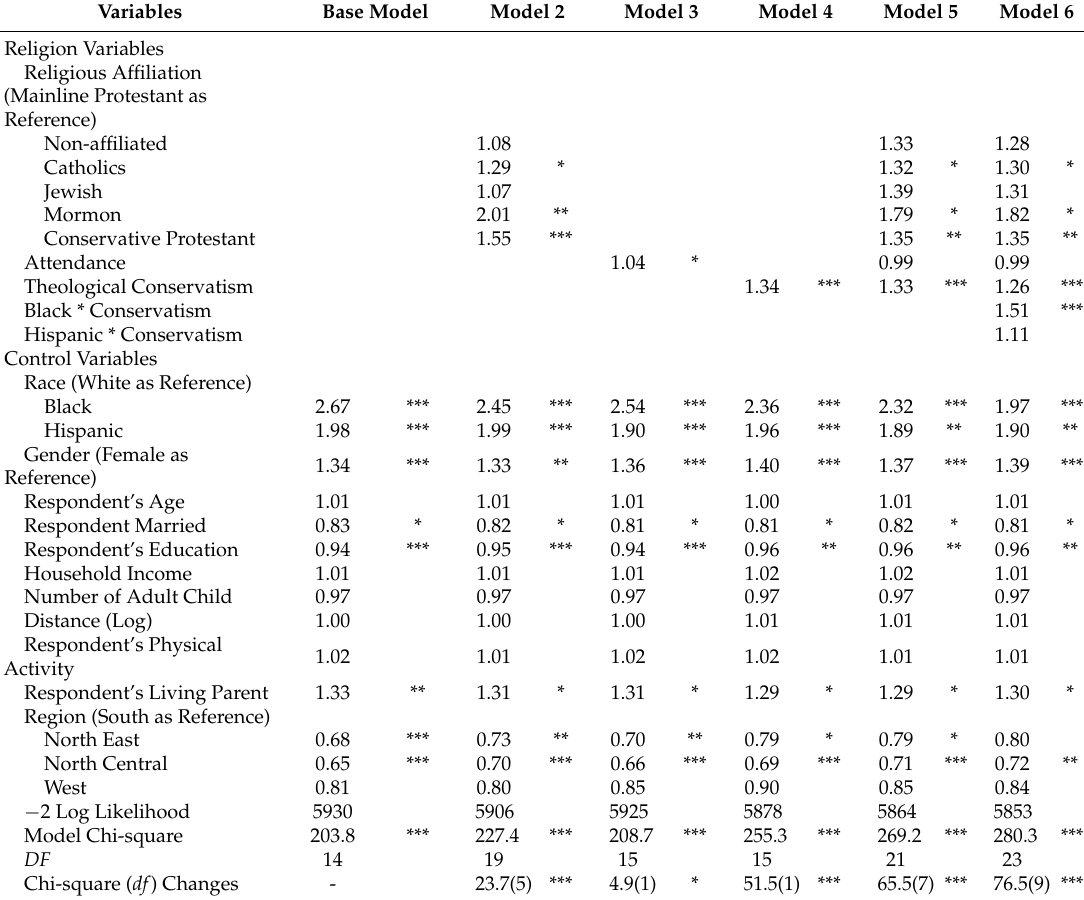
Table 5. Odds Coefficients of Ordered Logistic Regressions to Predict Children Ought to Provide Residence ( n =